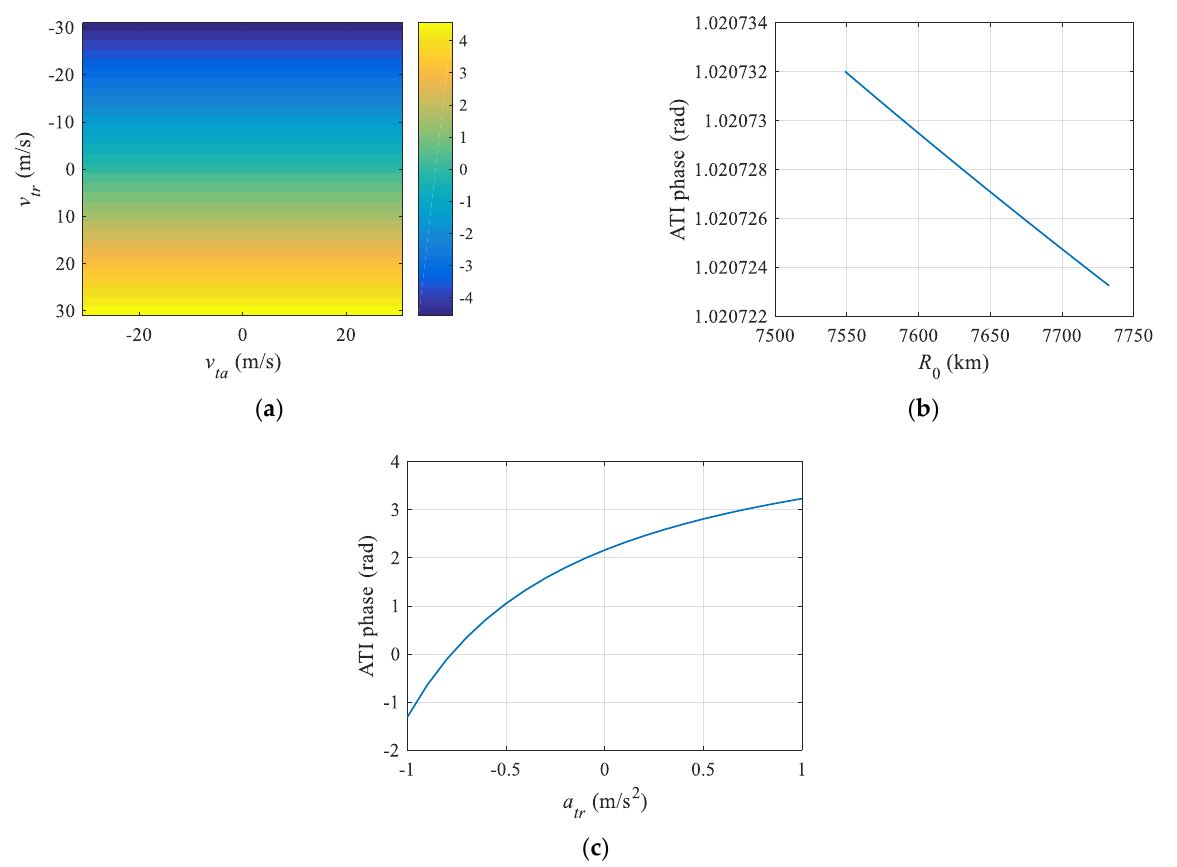
Figure 6. Variations of the ATI phase with the parameters of the target. ( a ) ATI phase versus v tr and v ta , where a tr = 0.1 m/s 2 , a ta = 0.2 m/s 2 , R 0 = 7568.7 km; ( b ) ATI phase versus R 0 , where a tr = 0.1 m/s 2 , a ta = 0.2 m/s 2 , v tr = 7 m/s, v ta = 15 m/s; ( c ) ATI phase versus a tr , where a ta = 0.1 m/s 2 , v ta = 20 m/s, v tr = 15 m/s, R 0 = 7568.7 km.